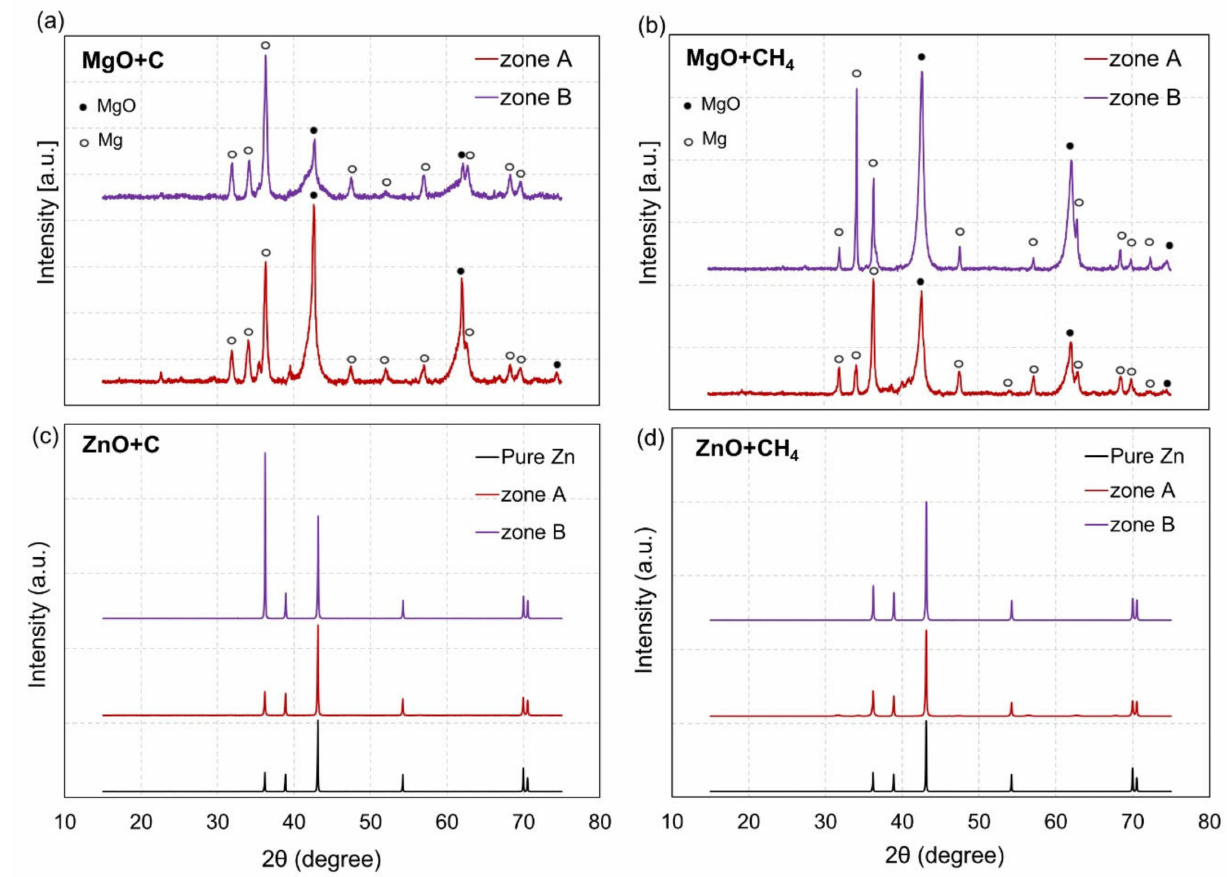
Figure 10. Representative XRD patterns of solid products from zone A and zone B: ( a ) the CTR of MgO, ( b ) the MTR of MgO, ( c ) the CTR of ZnO, and ( d ) the MTR of